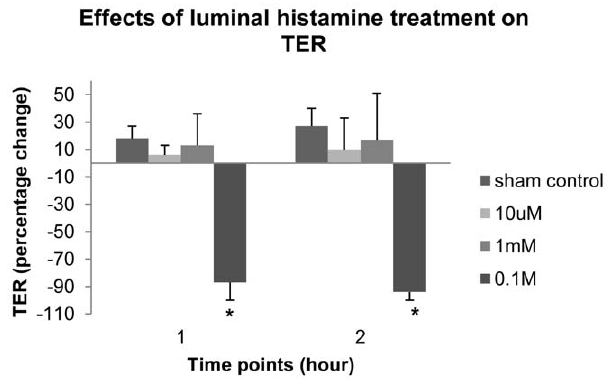
Figure 2. Luminal histamine treatments result in decreased TER. 0.1M luminal histamine treatment significantly (p , 0.05) decrease TER of native ovine vocal fold epithelia. Data represent the mean and standard deviation of percentage change in TER. The baseline value for TER (time 0) was 410 6 173.9 V ? cm 2